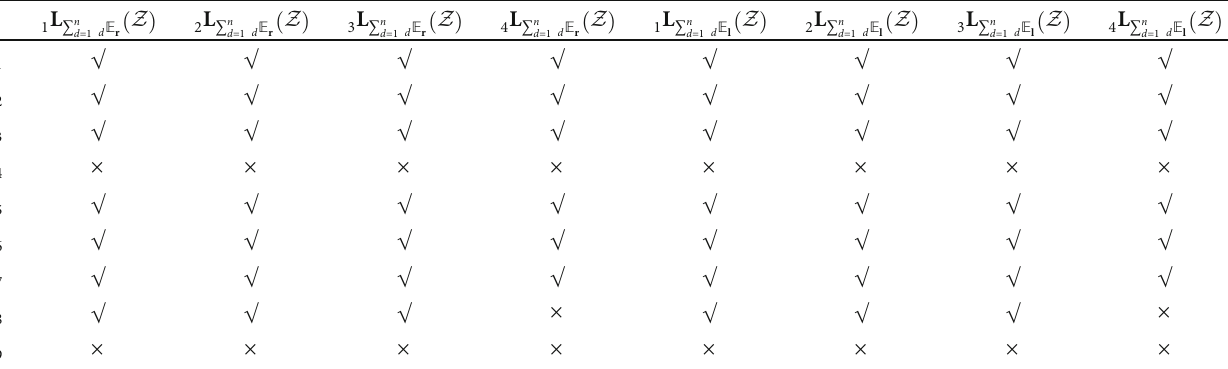
Table 1: Table for the lower approximations.